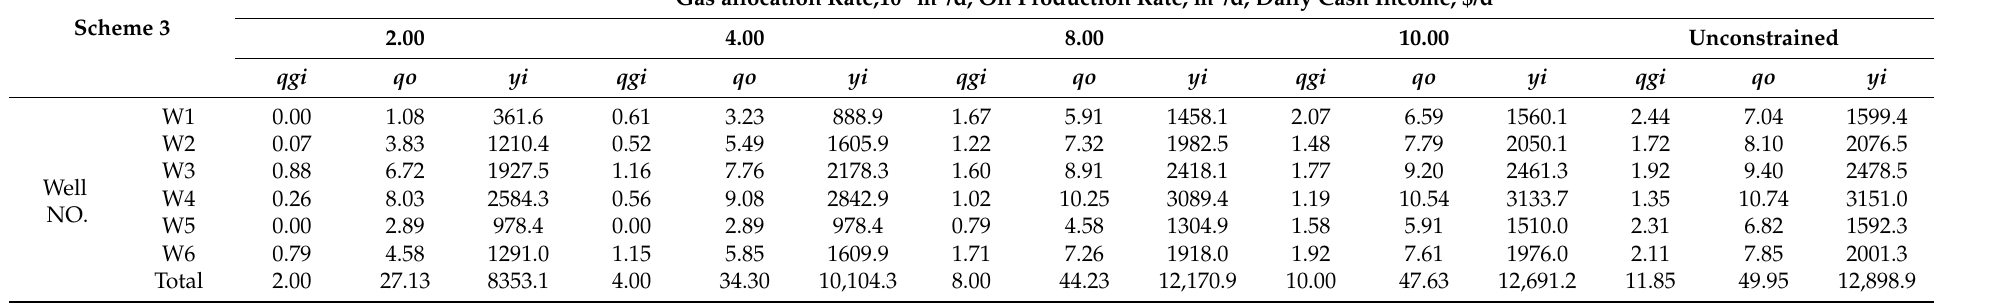
Table 10. Gas allocation result of various injected gas rate of Scheme 3.